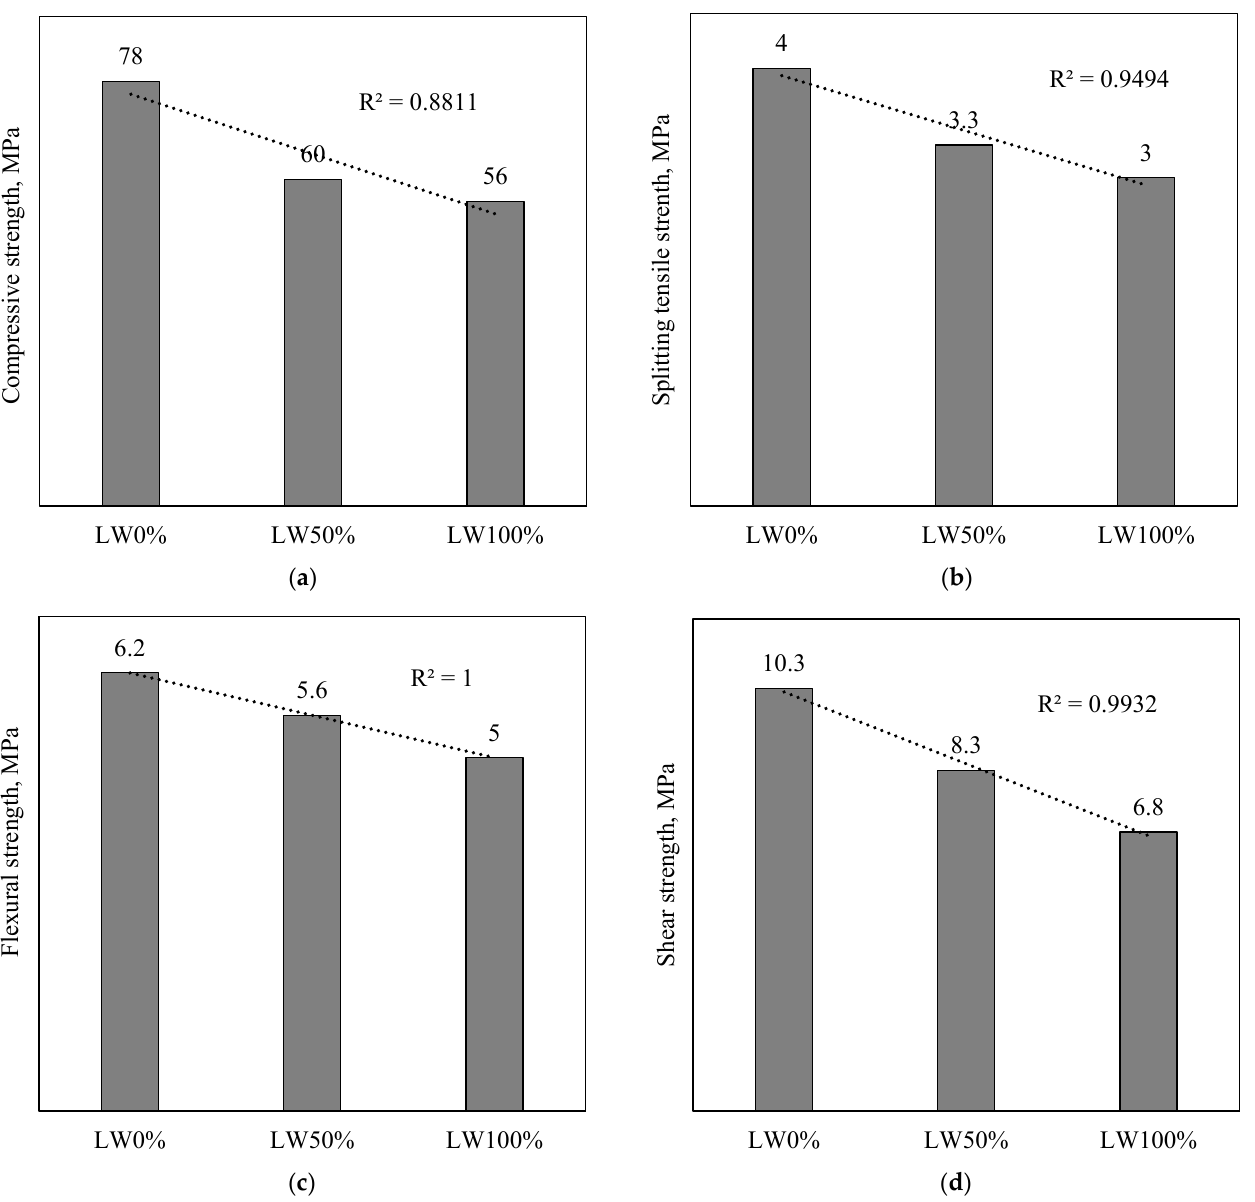
Figure 6. Reduction of mechanical strength of SCC by increasing the LWA proportion: ( a ) compressive strength, ( b ) splitting tensile strength, ( c ) flexural strength, and ( d ) shear strength. The splitting tensile strength of LWC is associated with its compressive strength and depends significantly on the curing condition [40]. Figure 6b shows that the splitting tensile strength decreases from 4 to 3.3 MPa when 50% of the coarse natural aggregate is replaced with LWA, and the reduction is higher when higher substitution is conducted. strength by 19% compared to that of LW0% (control mix). Other researchers [41] have